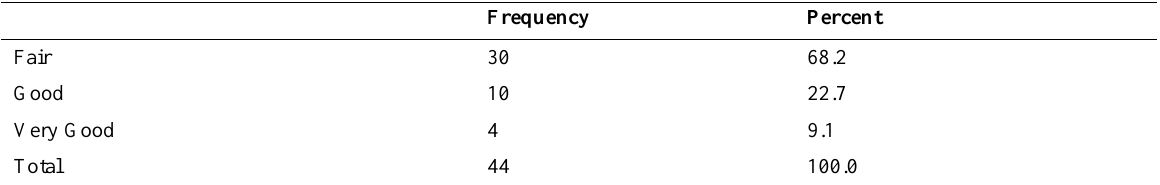
Table 4: General Financial Performance of